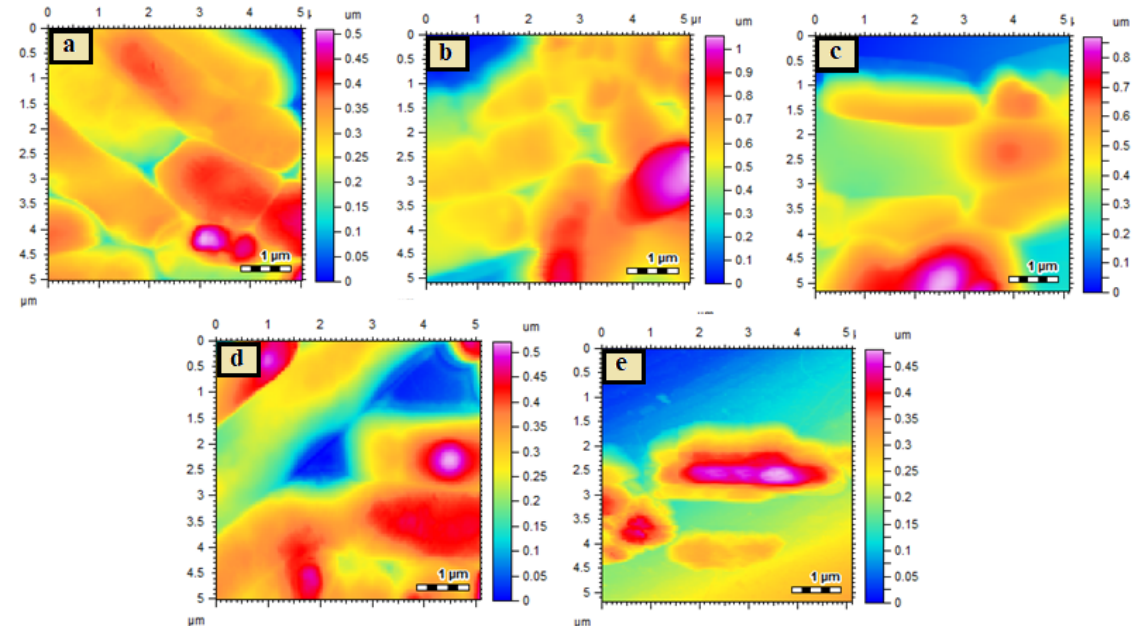
Figure 5. AFM images of H. pylori control cells ( a ), H. pylori AMX treated ( b ), H. pylori Zn-MOF treated ( c ), H. pylori Am-Zn-MOF treated ( d ), and H. pylori L-Am-Zn-MOF treated ( e ).